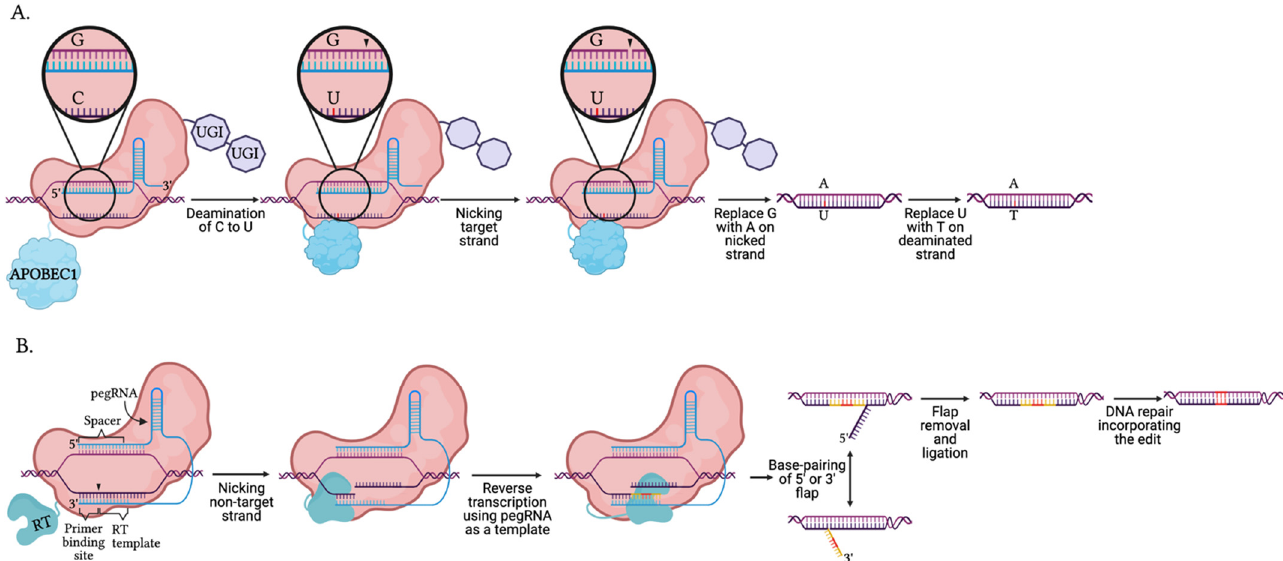
Figure 4. Mechanism of DNA base and prime editors using Cas9 nickase. ( A ) The illustrated generation 4 base editor (BE4) contains a nCas9 fused with two inhibitors uracil glycosylase inhibitors (UGI) and the cytosine deaminase, APOBEC1, capable of performing C to U transitions. APOBEC1 deaminates the target cytosine on the non-complementary strand, creating a uracil. The UGIs inhibit the repair machinery activated by the presence of the uracil base. nCas9 nicks the complementary strand and persuades the repair machinery to correct the non-deaminated strand, thereby promoting the incorporation of the edit. The final result is a C:G to T:A transition. ( B ). Prime editors contain a nCas9-reverse transcriptase (RT) fusion guided by an extended crRNA known as a primer editing guide RNA (pegRNA). The 5 ′ end of the pegRNA resembles a crRNA with a spacer region and a stem-loop. The 3 ′ end is extended to include a template containing the desired edit for the reverse transcriptase, and a 3 ′ primer binding site. The pegRNA guides nCas9 to the target DNA and forms Watson and Crick base-pairing at both the 5 ′ and 3 ′ ends. nCas9 nicks the PAM strand between the primer binding site and RT template. Using the primer binding site, the RT extends the PAM strand using the template containing the desired edit. Base pairing of the 3 ′ flap containing the edit leads to the removal of the 5 ′ flap. Through replication and DNA repair, the edit is incorporated into both strands.